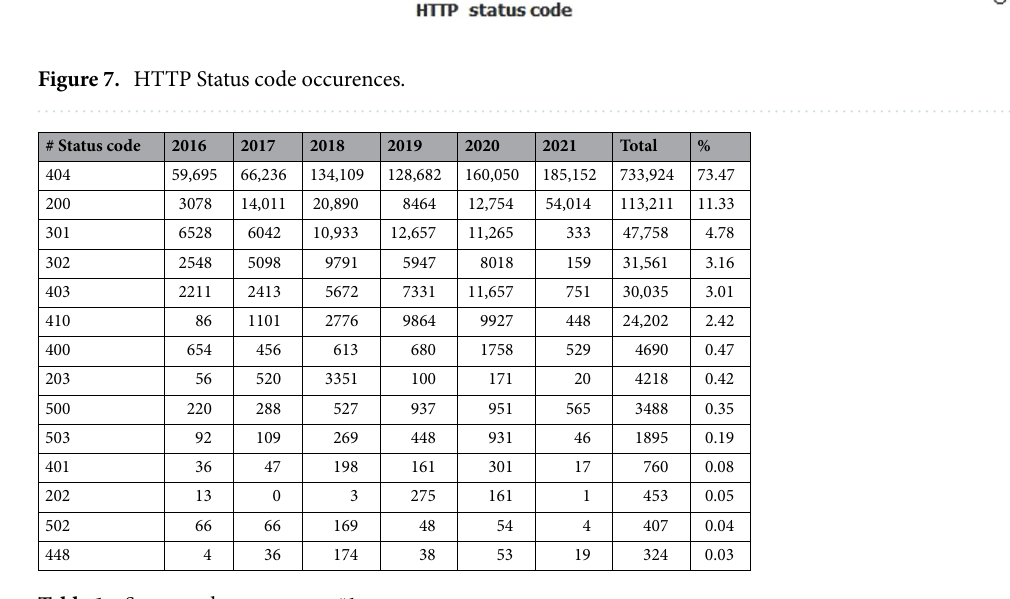
Table 1. Status code occurences